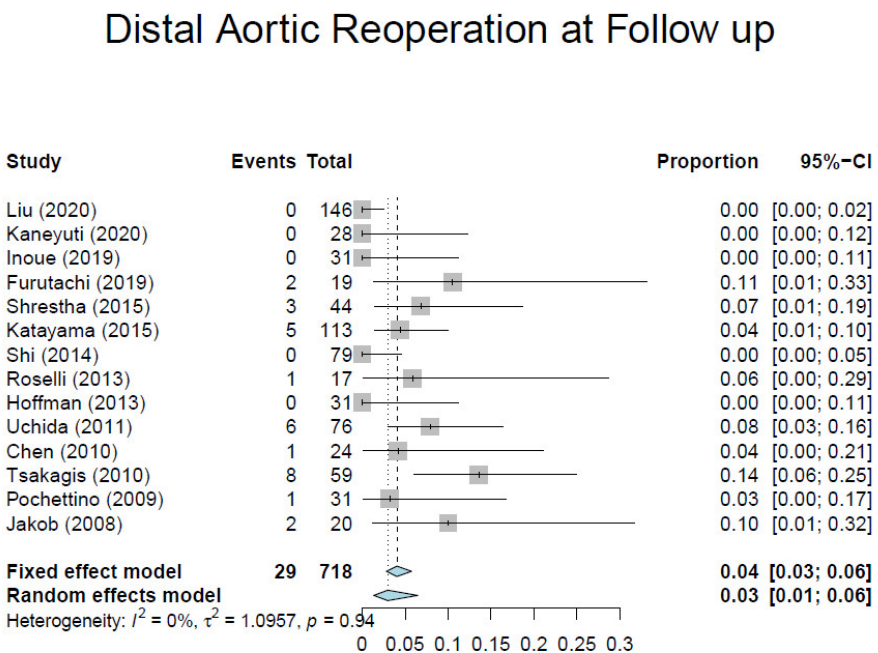
Figure 5. Forest plot depicting pooled estimates of spinal cord injury.